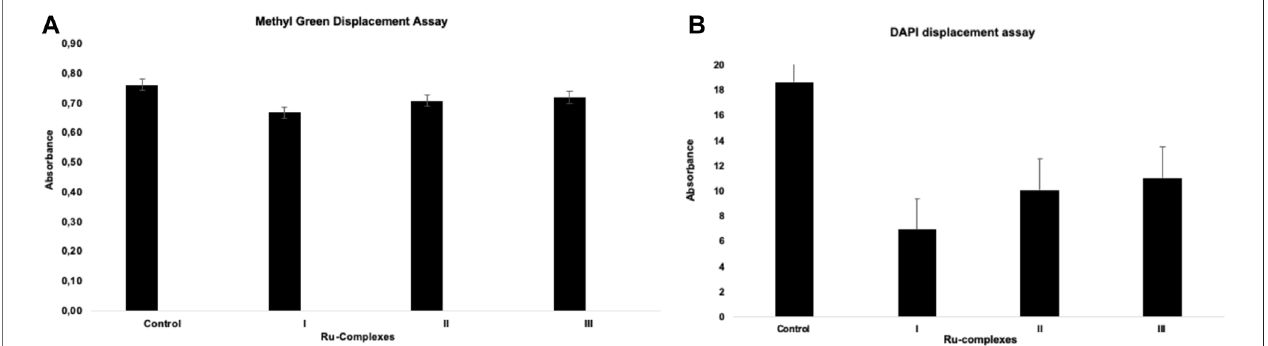
FIGURE 7 | Methyl green (A) and DAPI (B) absorbance in DNA binding competitive study.